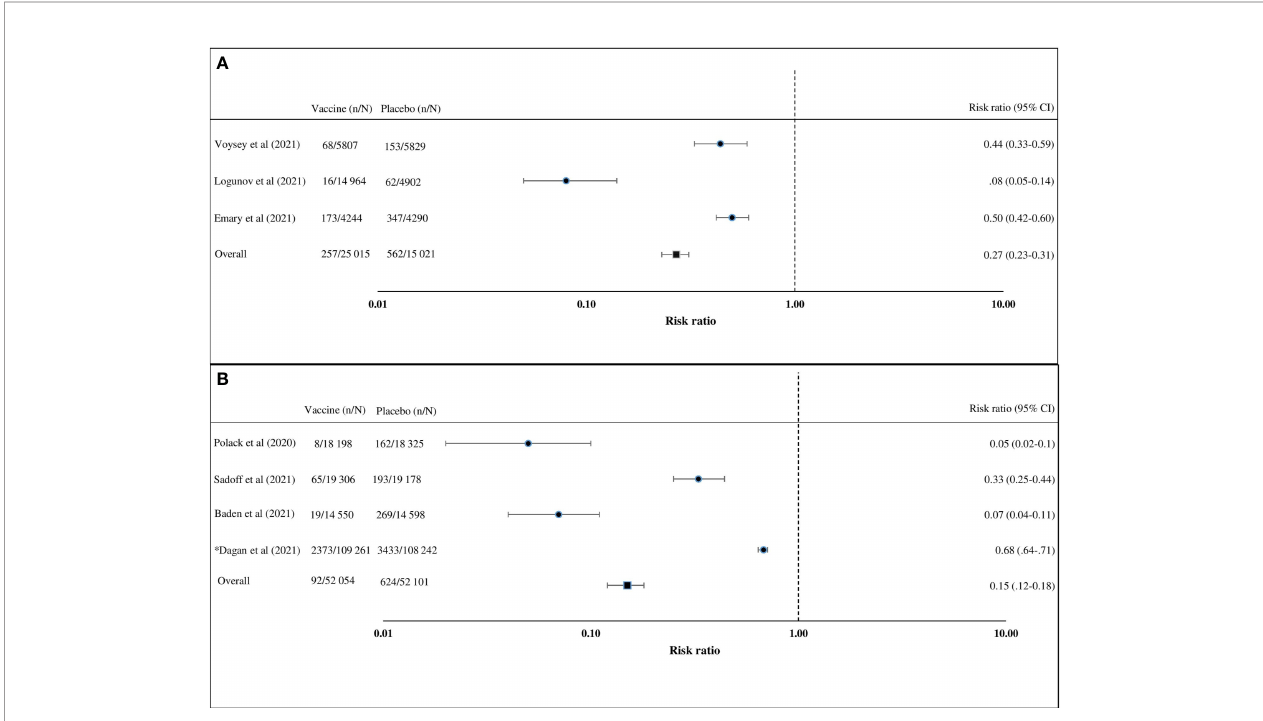
FIGURE 2 | Vaccine ef fi cacy compared with placebo calculated using the Mantel – Haenszel random effects model. (A) Adenovirus vector vaccines in participants aged 18 years or above. (B) Messenger RNA (mRNA) vaccines in participants aged 16 years or above. Prospective studies (risk ratio) were included in this analyses. n , cases of COVID-19; N , group